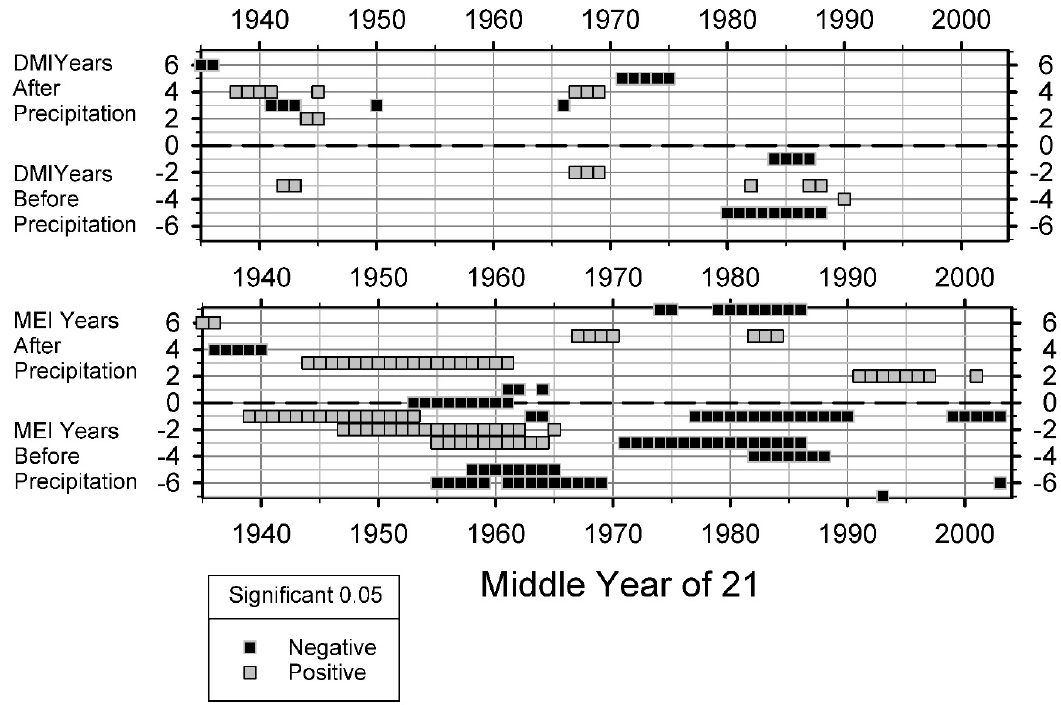
Figure 8. Significant lag-cross correlations between standardized precipitation (1925–2013) and the DMI ( upper ) and MEI ( lower ) viewed through a 21-year window over lags +7 to − 7 years.